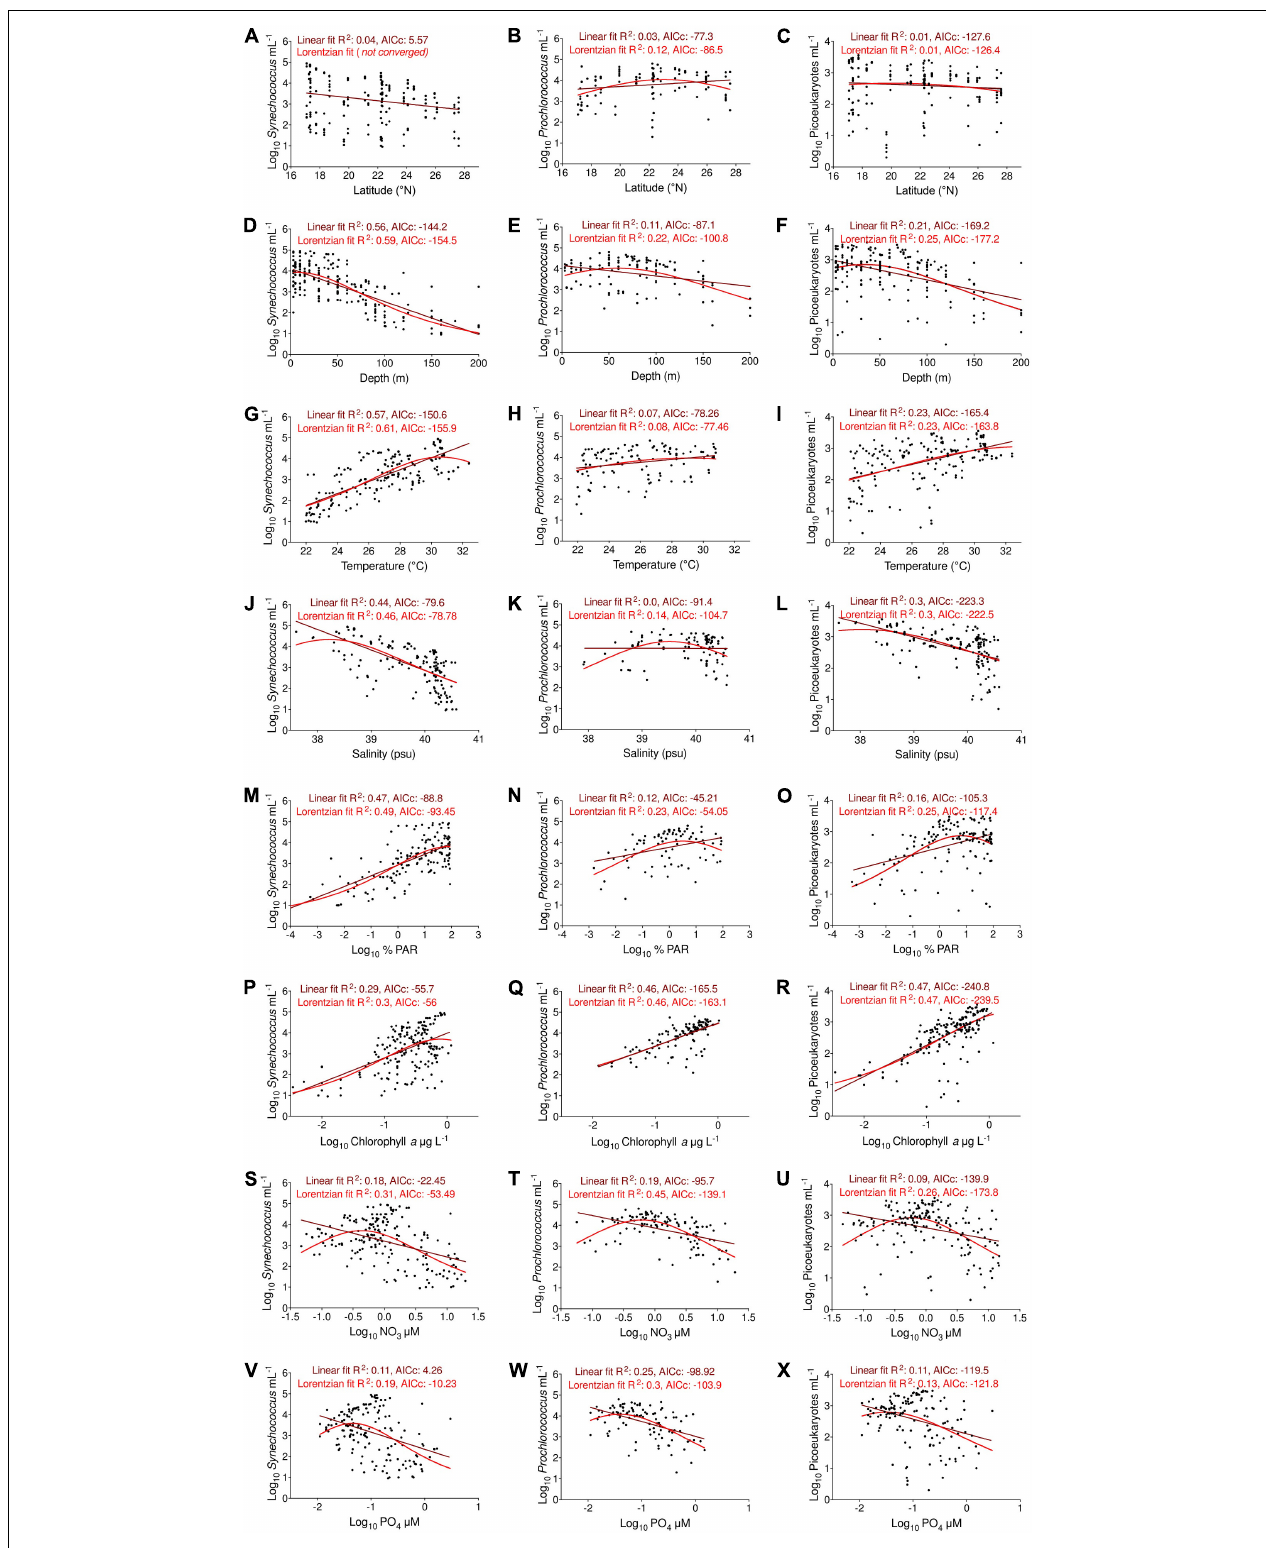
FIGURE 4 | Relationships between the abundances of the three picophytoplankton groups under changes in (A–C) latitude, (D–F) depth, (G–I) temperature, (J–L) salinity, (M–O) %PAR, (P–R) chlorophyll a , (S–U) nitrate, and (V–X) phosphate concentrations in the Red Sea. Straight lines represent linear regression fits (brown) and Lorentzian curves (red). The R 2 and AICc index for both fits are indicated at the top of each plot.